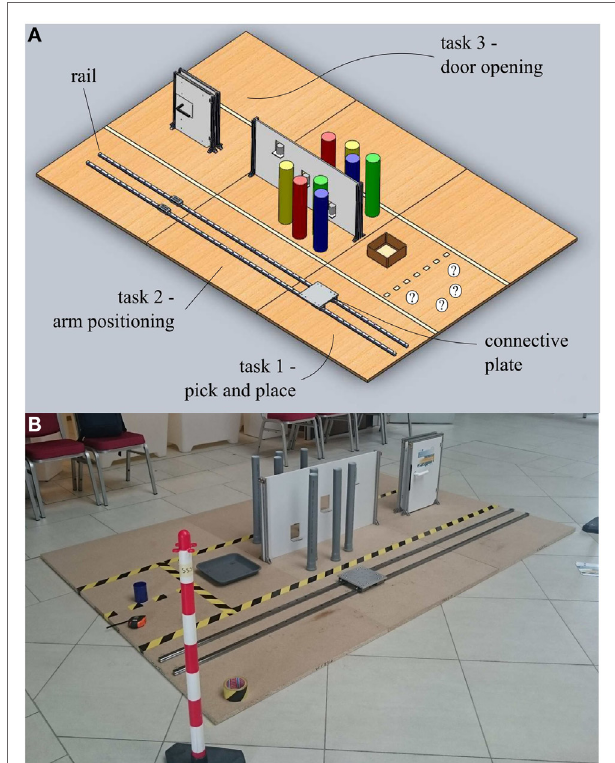
FIGURe 3 | the manipulation scenario was made of three tasks, which can be approached from two sides (with and without a mobile base) . Picture (A) shows the CAD model, picture (B) shows the actual implementation.